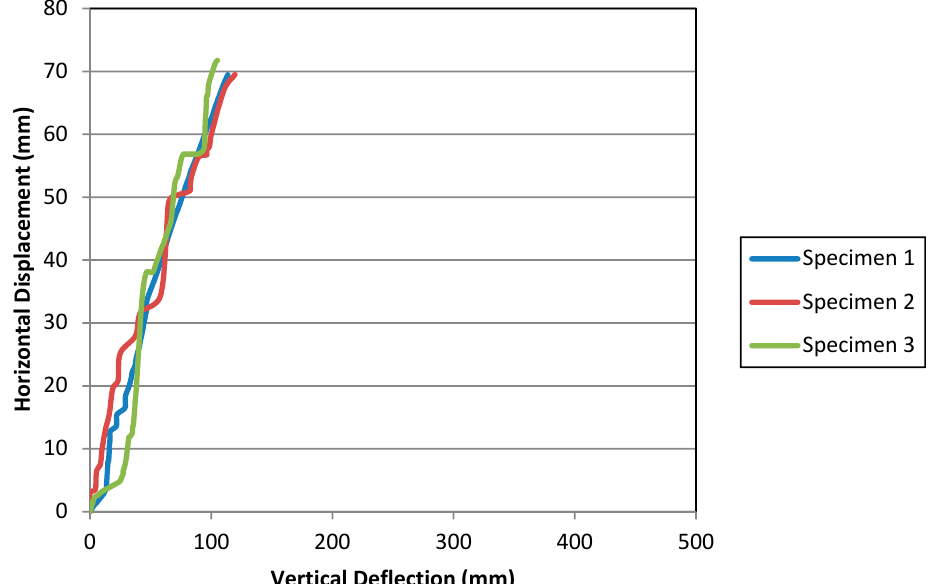
Figure 24. Horizontal displacement at the bottom LVDT versus vertical deflection.